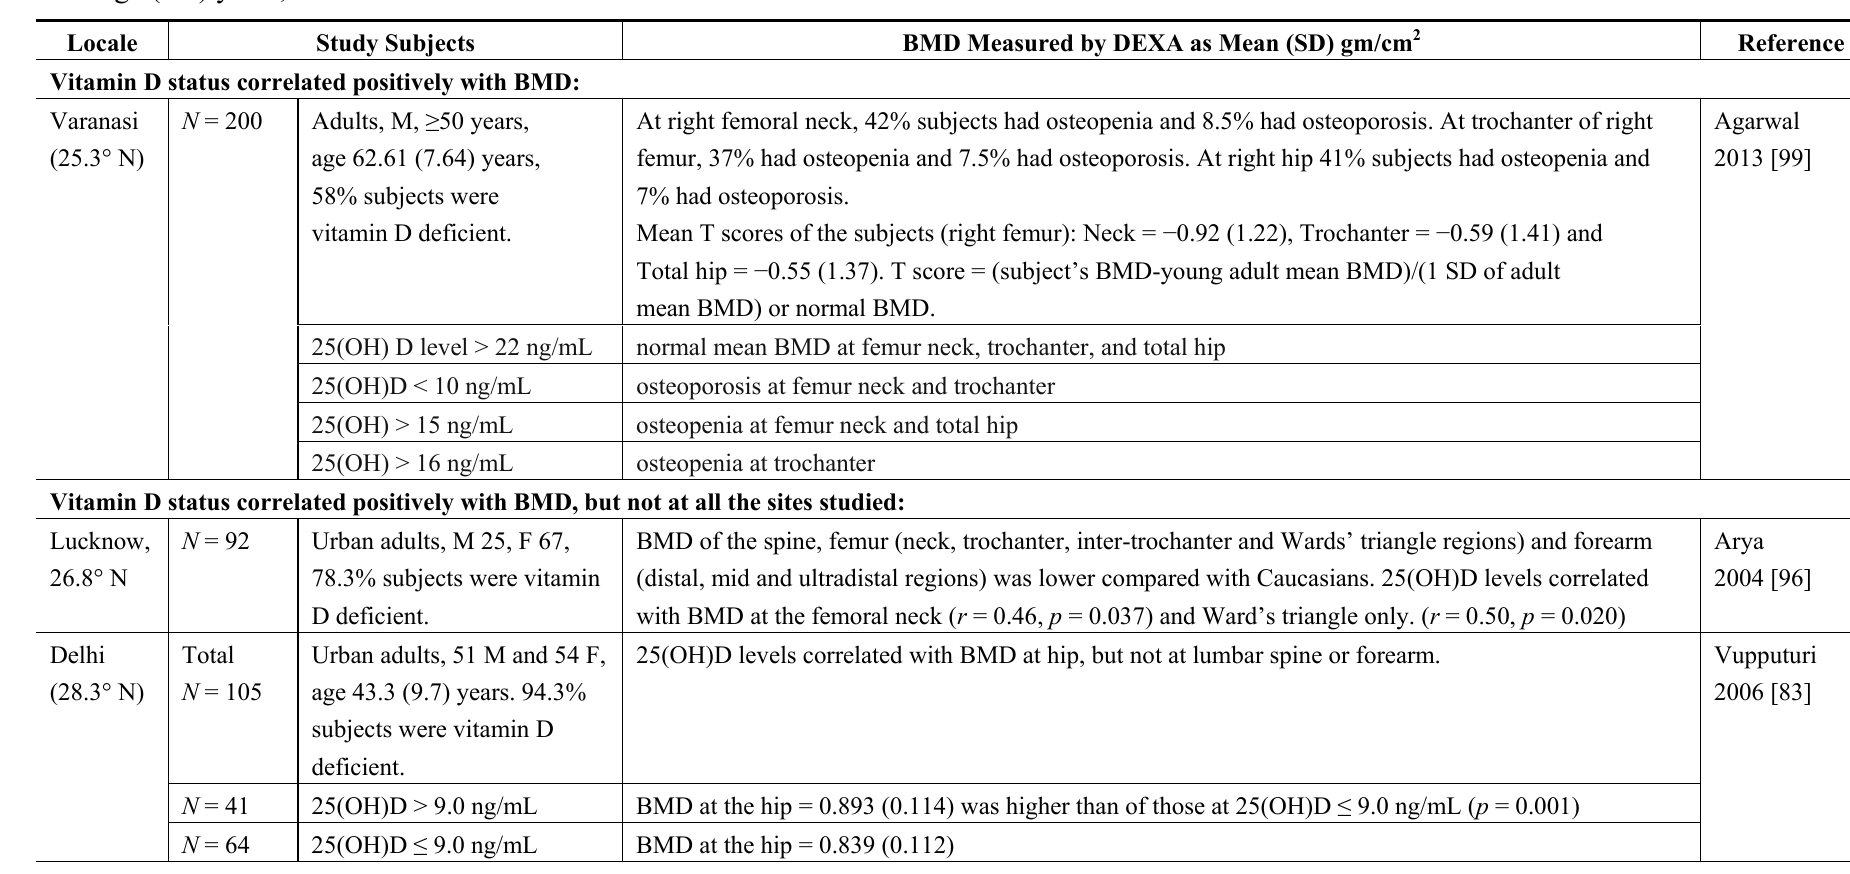
Table 2. Vitamin D status and its correlation with bone mineral density (BMD) in ostensibly healthy Indians. For additional details of vitamin D status, see Table 1. All 25(OH)D values have been shown in ng/mL. To convert from nM to ng/mL, nM values were divided by (2.5). Vitamin D deficiency is defined as 25(OH)D < 20 ng/mL. DEXA is Dual Energy X-ray Absorptiometry. Age of the subjects is in mean age (SD) years, unless otherwise